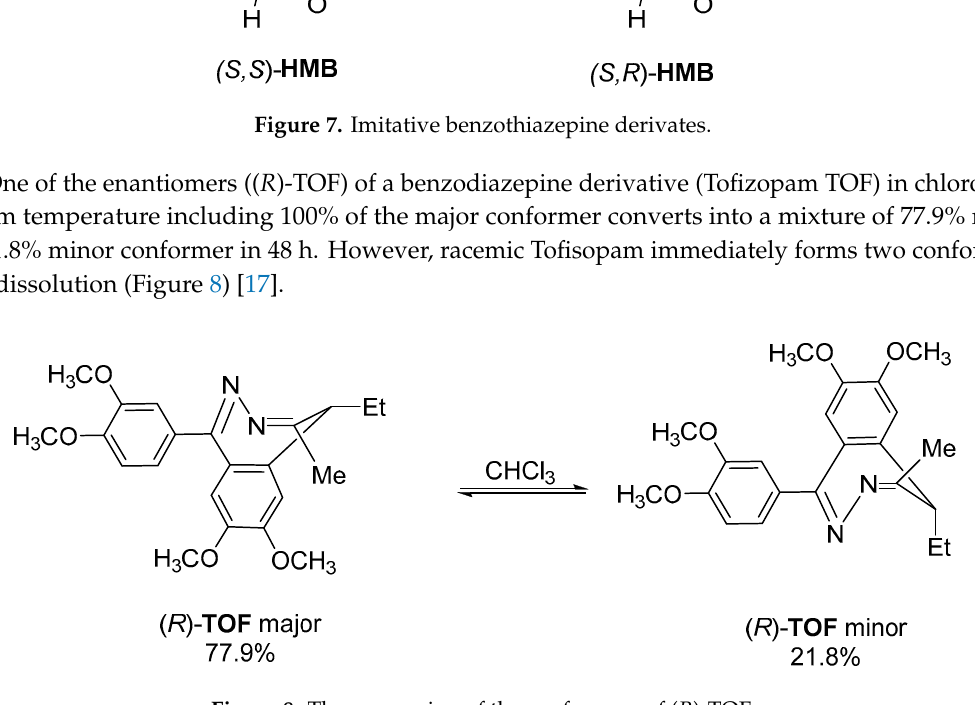
Figure 9. Diastereomeric salt formation with both conformers.